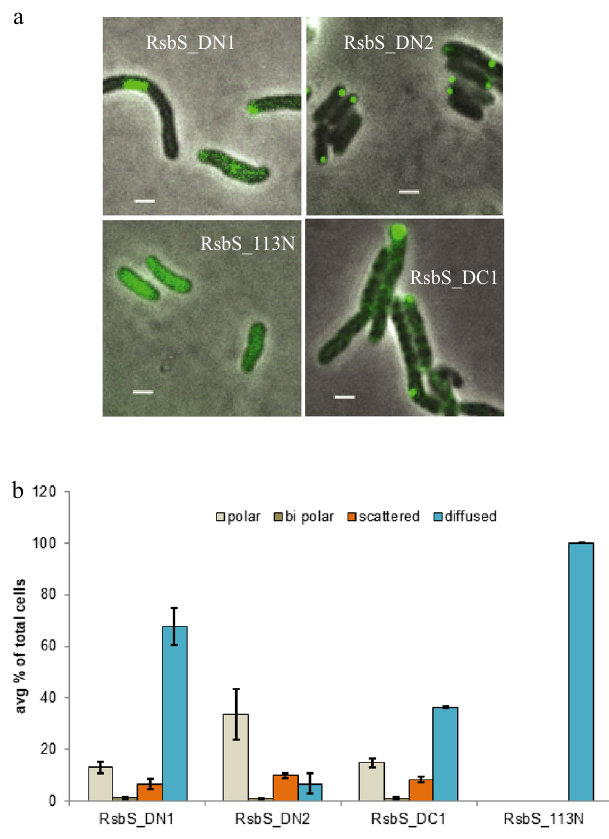
Figure 4. Intracellular localization of RsbS deletions. ( a ) Shows the RsbS localization in Mmar pST2K-RsbS-GFP fusion cells with N and C terminal deletions of RsbS, scale bar = 1 μm. ( b ) Shows the average percentage distribution of the different types of localizations in the RsbS (N- and C-termini) deletion constructs in the exponential phase with standard deviations. A minimum of 500 cells were considered for each time